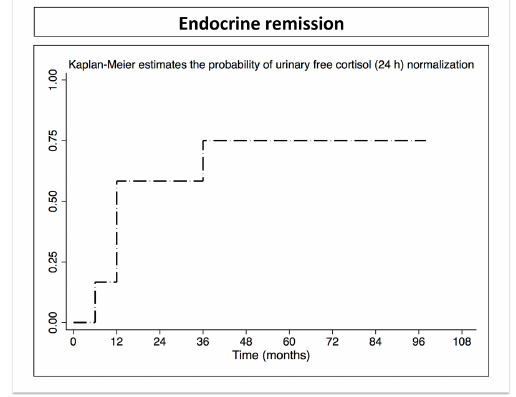
Figure 1: Probability of biological remission in the absence of pharmacological treatment after Gamma Knife radiosurgery; the number of patients for the time-points at 12, 24, 36, 51 and 96 months were 21, 15, 11, 7 and 3,